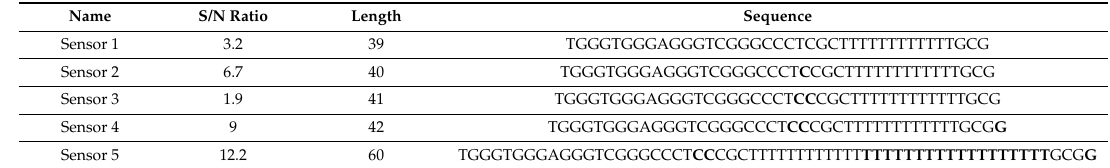
Table 2. Sequence information for each optimization